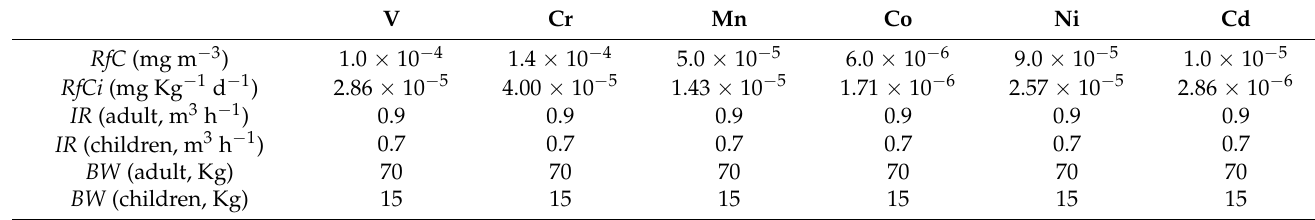
Table 1. RfC data from USEPA database. RfDi values were calculated according to equation (2), using the reported values of IR and BW for adults and children. Standard default exposure factors were used, taking into account the “inhalation of contaminant” as the exposure pathway in a “residen- tial scenario” related to adults and children (male and female combined), for sedentary and light activity